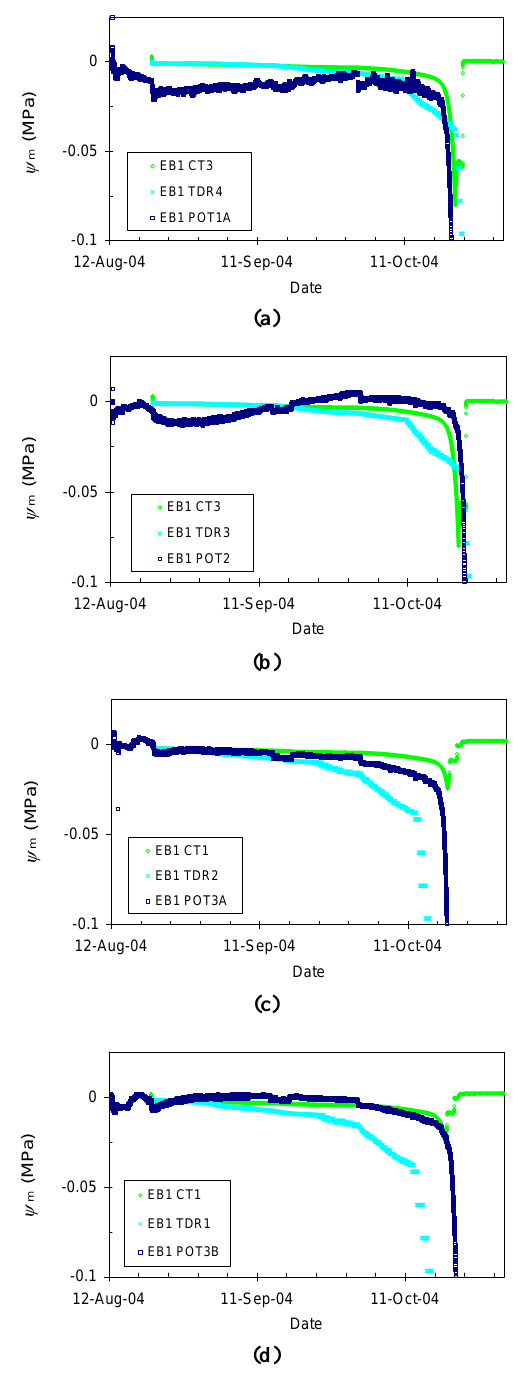
Fig. 5. Development of the matric potential ψ m in time (detail of Fig. 4) measured by polymer tensiometers (POT), time domain reflectometry probes (TDR) and water-filled tensiometers (CT) in evaporation container 1 (EB1) that was filled with sand. Each sub- figure shows a POT-TDR pair installed opposite to one another, and the nearest